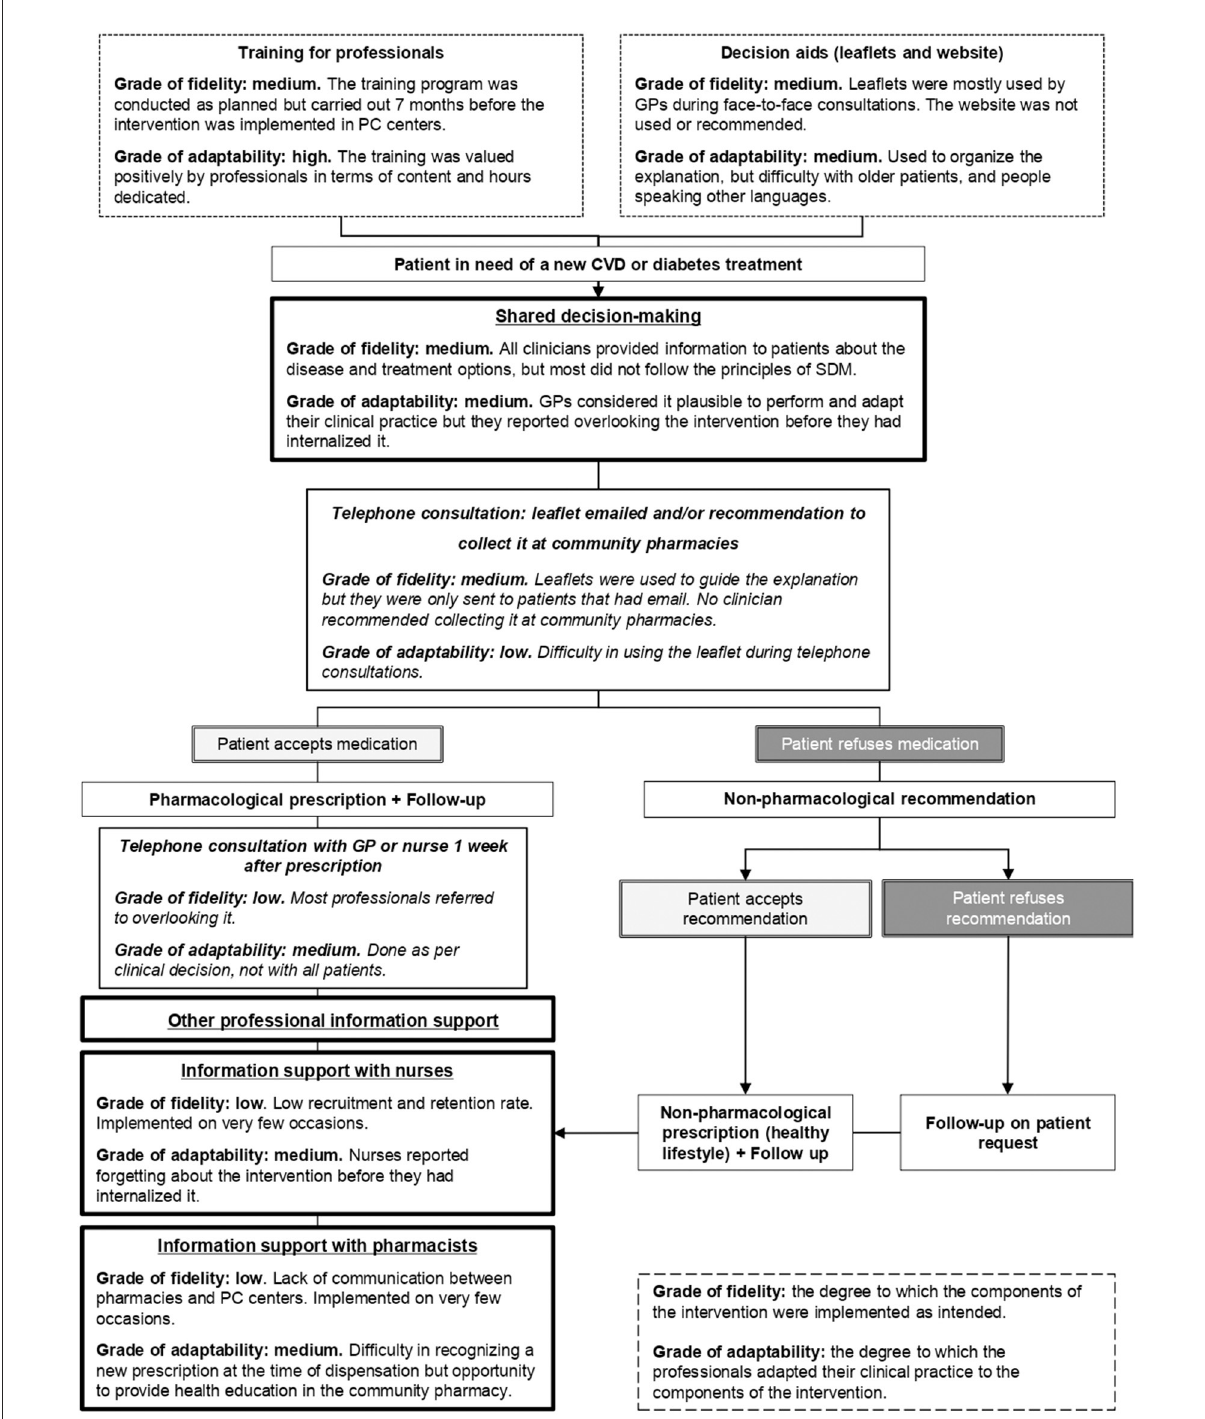
FIGURE3 Grade of fidelity and adaptability to the implementation strategy and processes of the IMA intervention. CVD, cardiovascular disease; GP, general practitioner; PC, primary care. Text in italics describes the intervention adaptations made due to the COVID-19 pandemic.